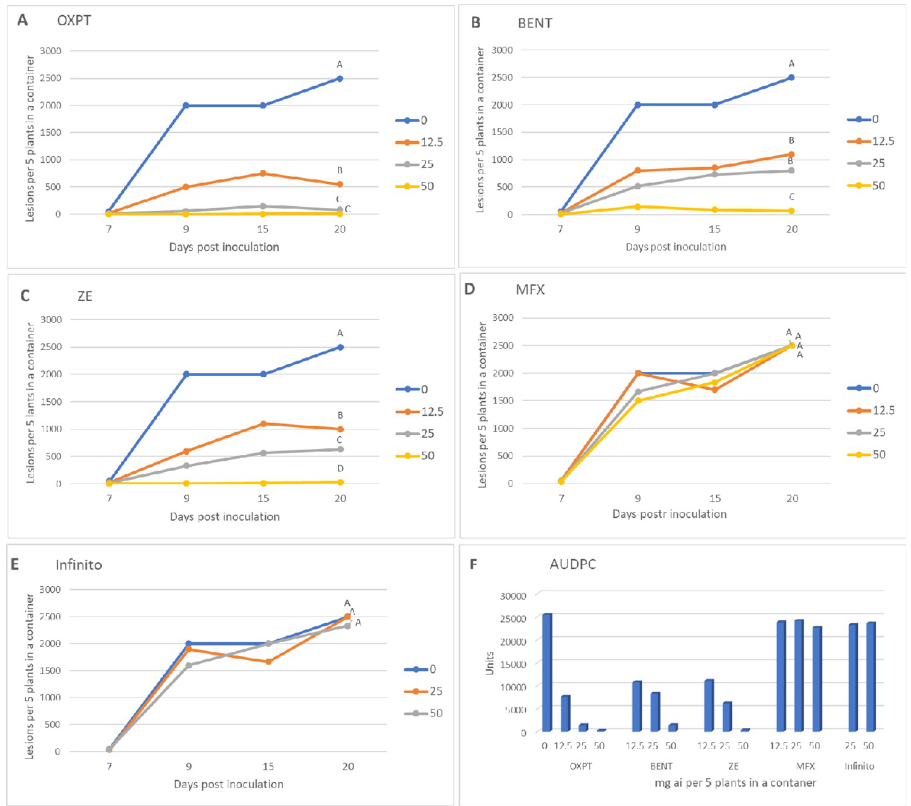
Fig 3. Systemic protection of potato Nicola against late blight caused by an MFX-resistant isolate of Phytophthora infestans under field conditions. Potato plants grown in 64 L containers were treated by a soil drench of 12.5, 25, or 50 mg ai fungicide suspension per container (n = 3). At 21 days after treatment the plants were inoculated with a sporangial suspension of isolate 164 of the pathogen. Percent leaf area occupied by late blight lesions was visually recorded at various time intervals after inoculation. Different letters on the curves indicate on significant differences between treatment at 20 dpi (t-test, α = 0.05). A- oxathiapiprolin. B- Benthiavalicarb. C- Zorvec Endavia. D- Infinito. E- Mefenoxam. F- Area under disease progress curve.